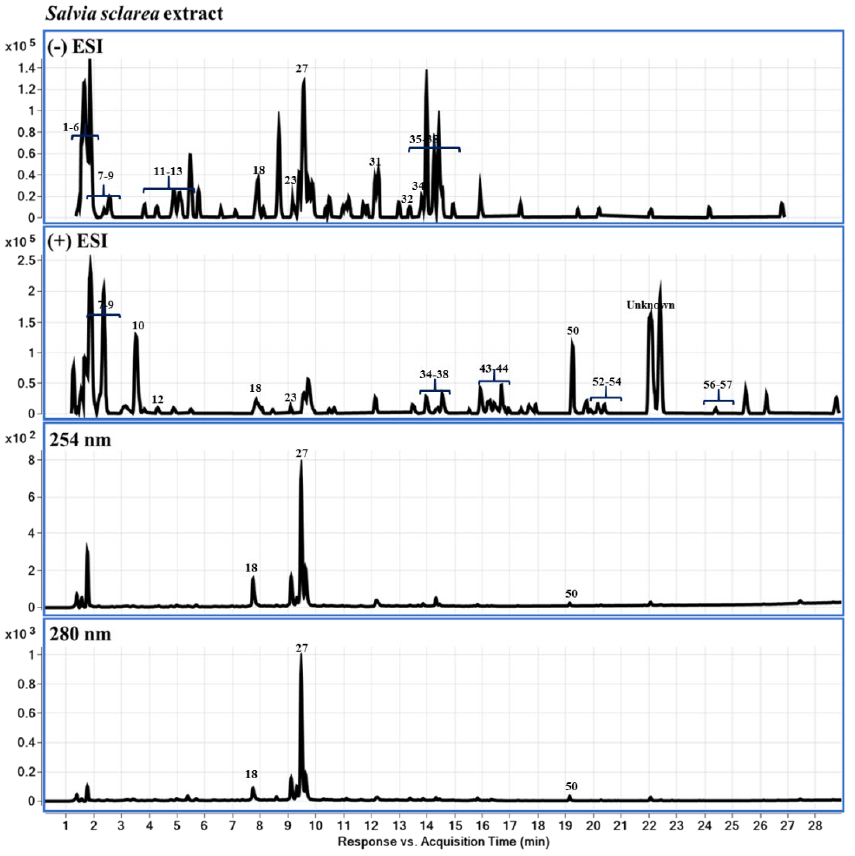
Figure 4. Base peak chromatograms (BPC) from S. deserta Schang. and S. sclarea L. extracts LS-2 and LS-4 in ESI positive ion mode. Each sample was injected twice.